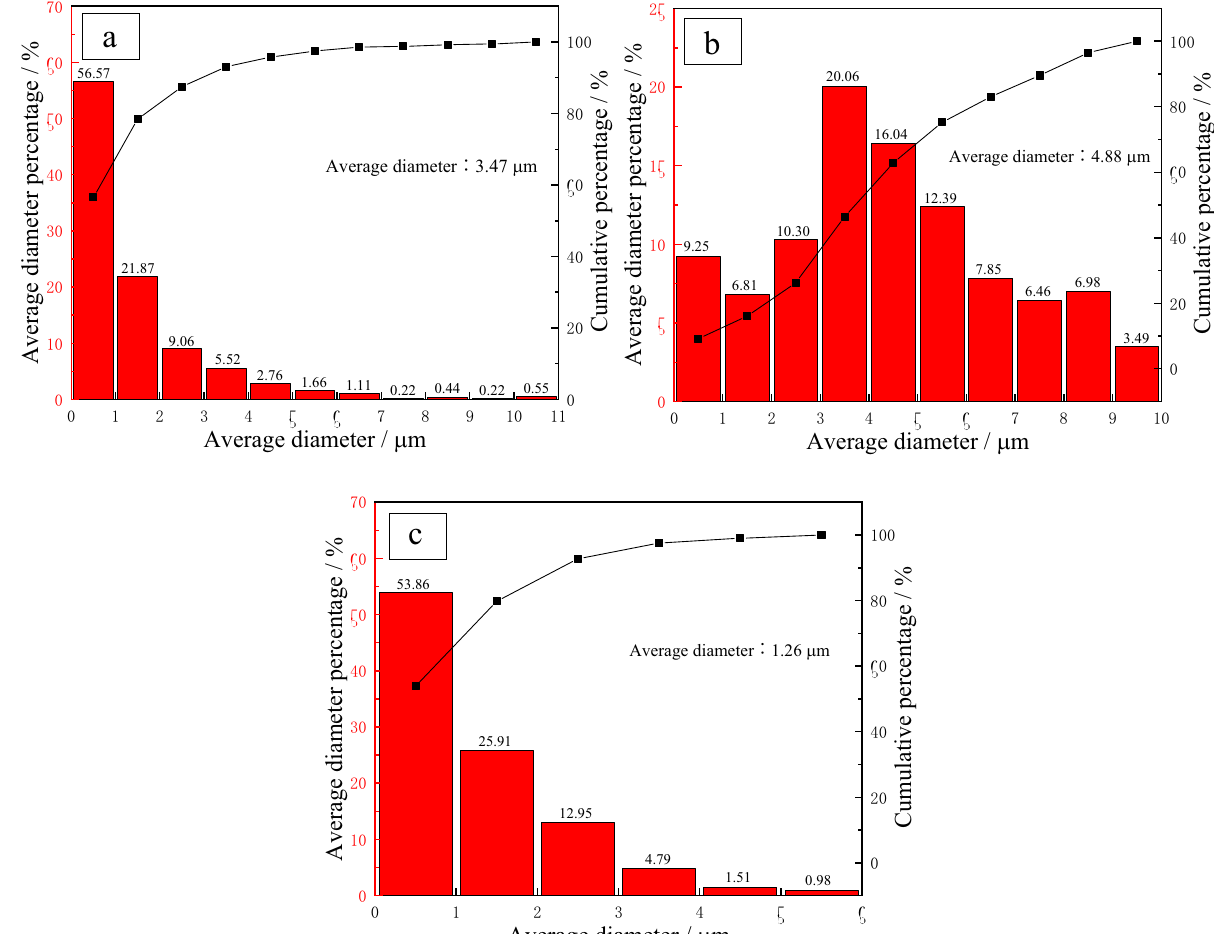
Figure 5: W particle distributions in microstructure of WCu composites microalloyed with ( a ) Fe, ( b ) Ni, and ( c ) Mn.